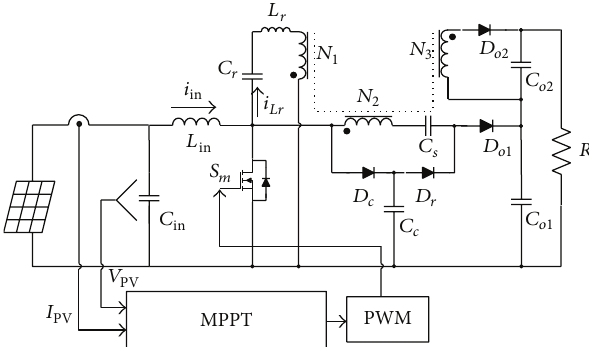
Figure 1: The proposed PV system with MPPT controller.